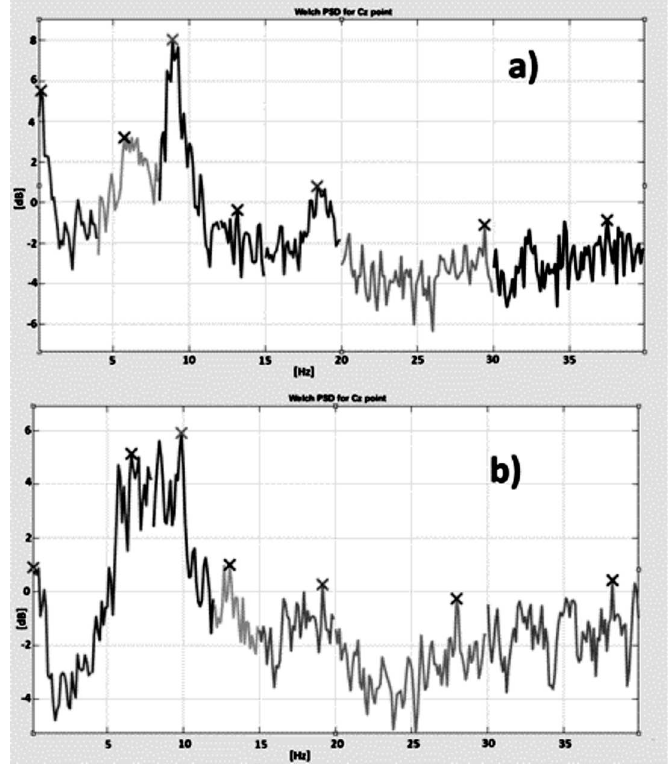
Figure 10. Spectrograms before (a) and after the Neurofeedback therapy (b) for type